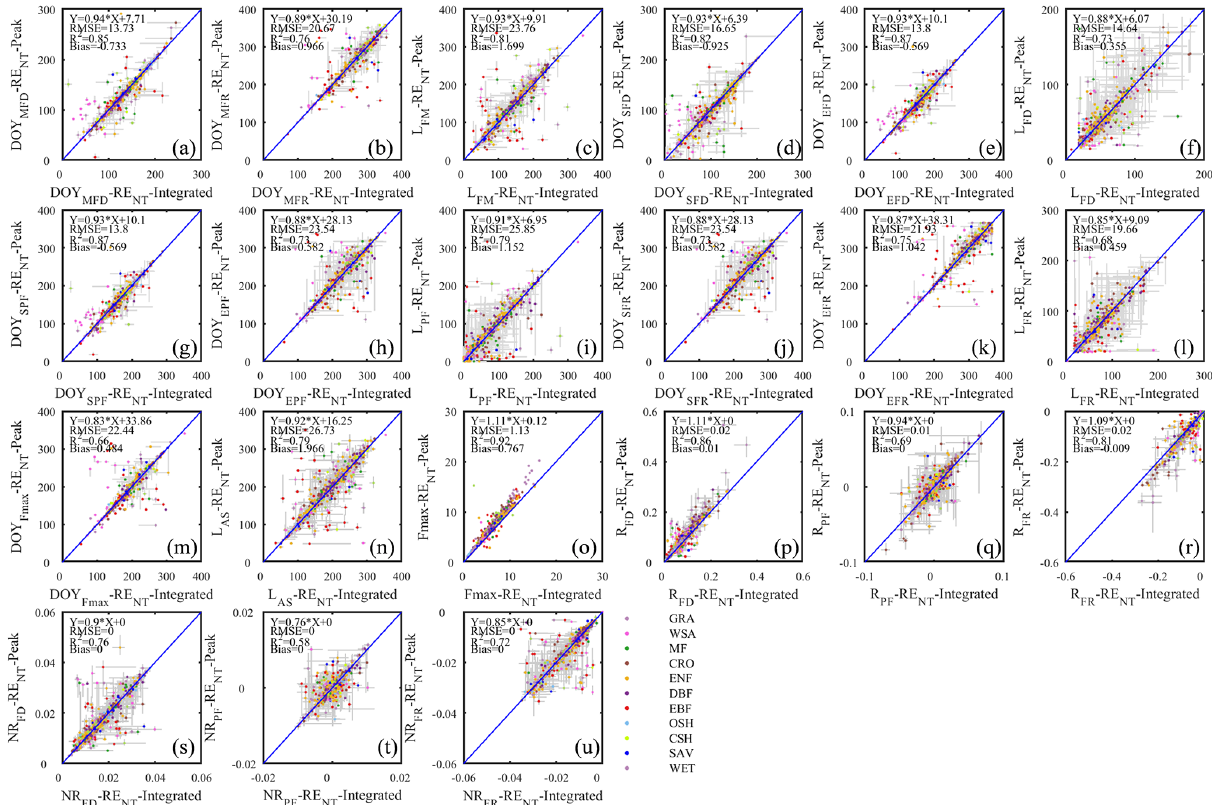
Figure 5. The scatter plots of different phenology metrics from RE-NT daily integrated data and RE-NT daily peak data.